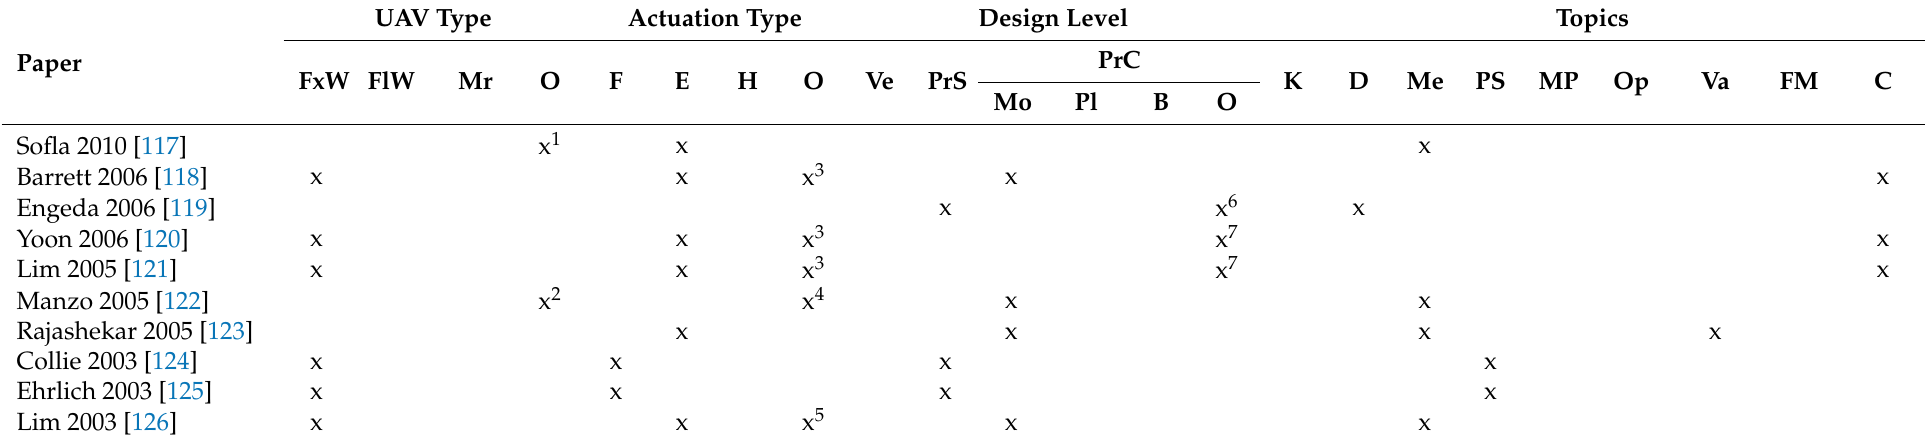
Table 11. Evaluation of the papers categorized in the detailed design category until 2010, according to the taxonomy referring to the paper